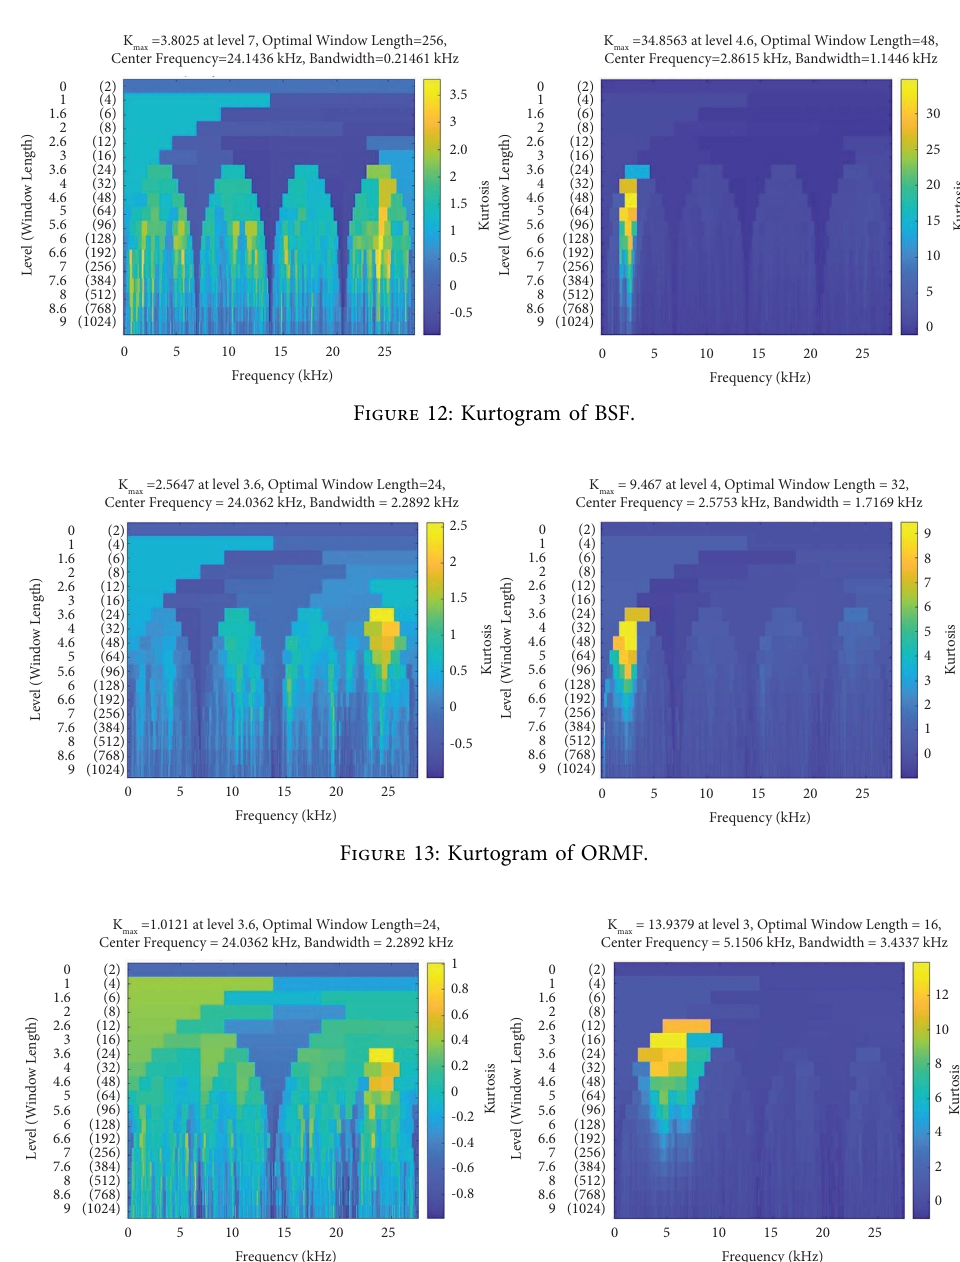
Figure 14: Kurtogram of